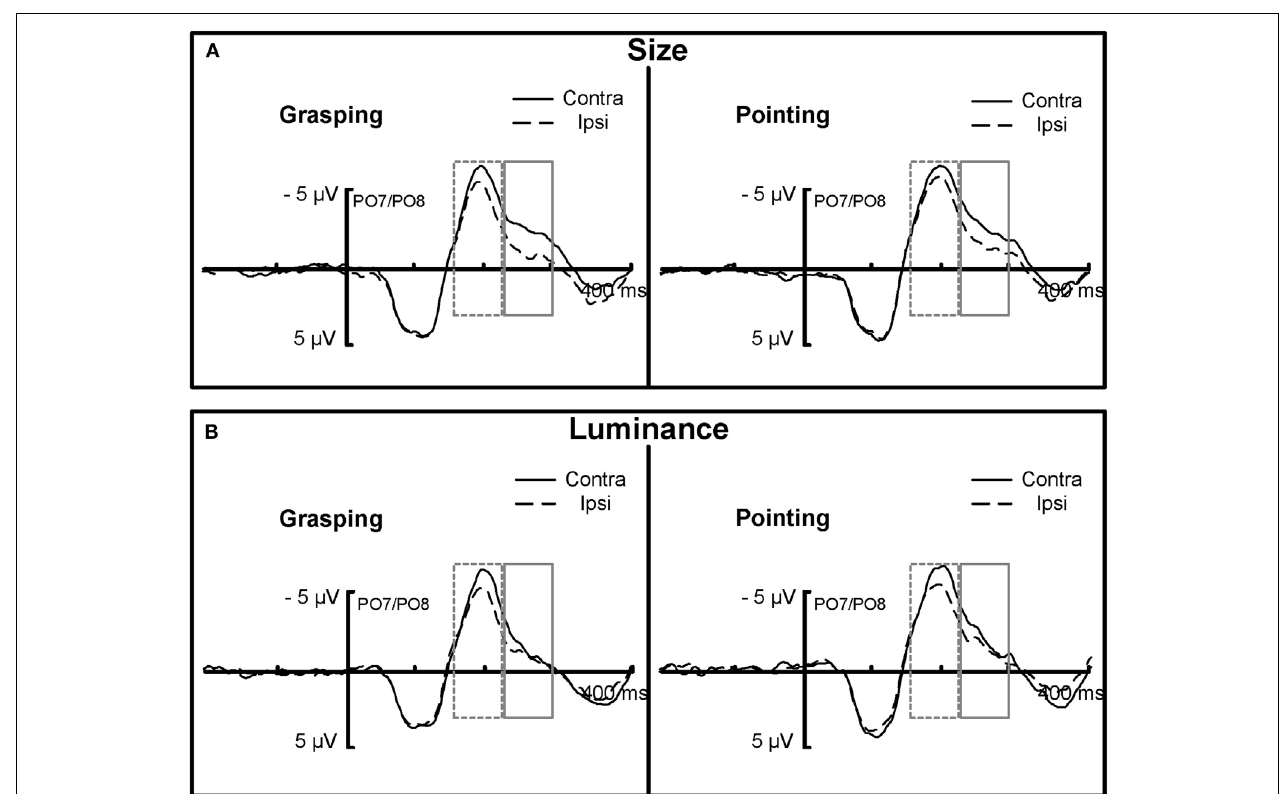
mark the time window (230–300ms) in which an action-related modulation was observed for size targets: N2pc was larger for size-and-grasping as compared to size-and-pointing. No such differential effect was observed for luminance targets in this time window.The dashed boxes represent the earlier time window in which a general N2pc was observed for both luminance and size